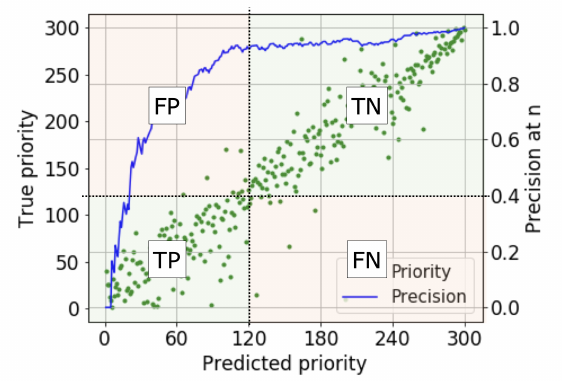
Figure 6. Precision at n used as an accuracy metric in the study. Precision is chosen as the specific accuracy metric as the main objective is to prevent downlink of cloudy images. The figure shows an evaluation example of precision at